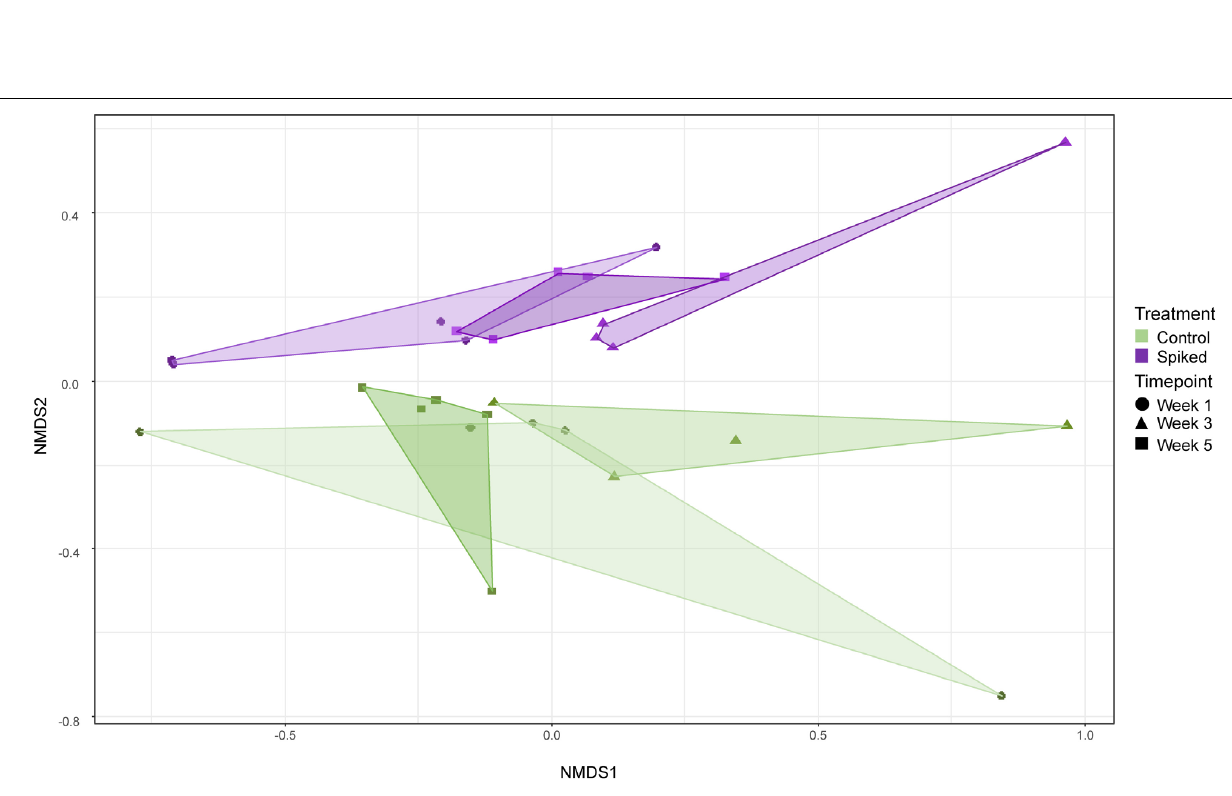
FIGURE 3 | NMDS of the 16S rRNA data with Bray-Curtis distance, based on data for all timepoints. The overlying triplot shows the results of the bio.env analysis. The circles denote control replicates (green) and sediment spiked with the chemical mixture (purple), (stress = 0.07, Spearman’s rho = 0.84).